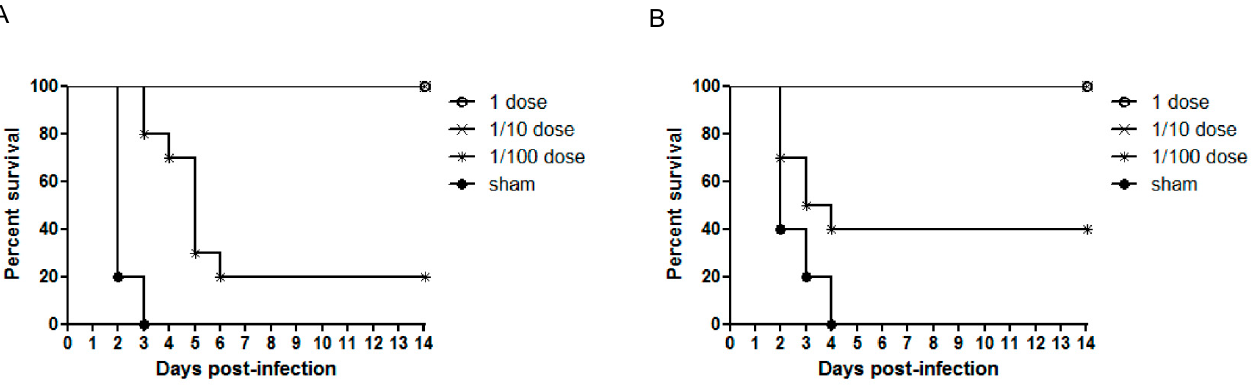
Figure 2. Survival of chickens inoculated with a single dose of one of the two inactivated vaccines (a full dose, a 1/10 dose, a 1/100 dose, or sham) and then challenged with highly pathogenic H5 viruses. ( A ) rgCA2/2.3.2.1d. ( B ) rgES3/2.3.4.4h.